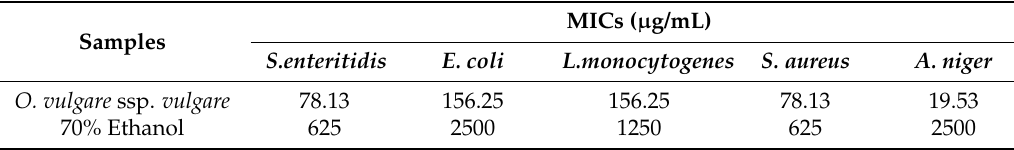
Table 4. Minimum inhibitory concentration (MIC) values of O. vulgare ssp. vulgare extract.